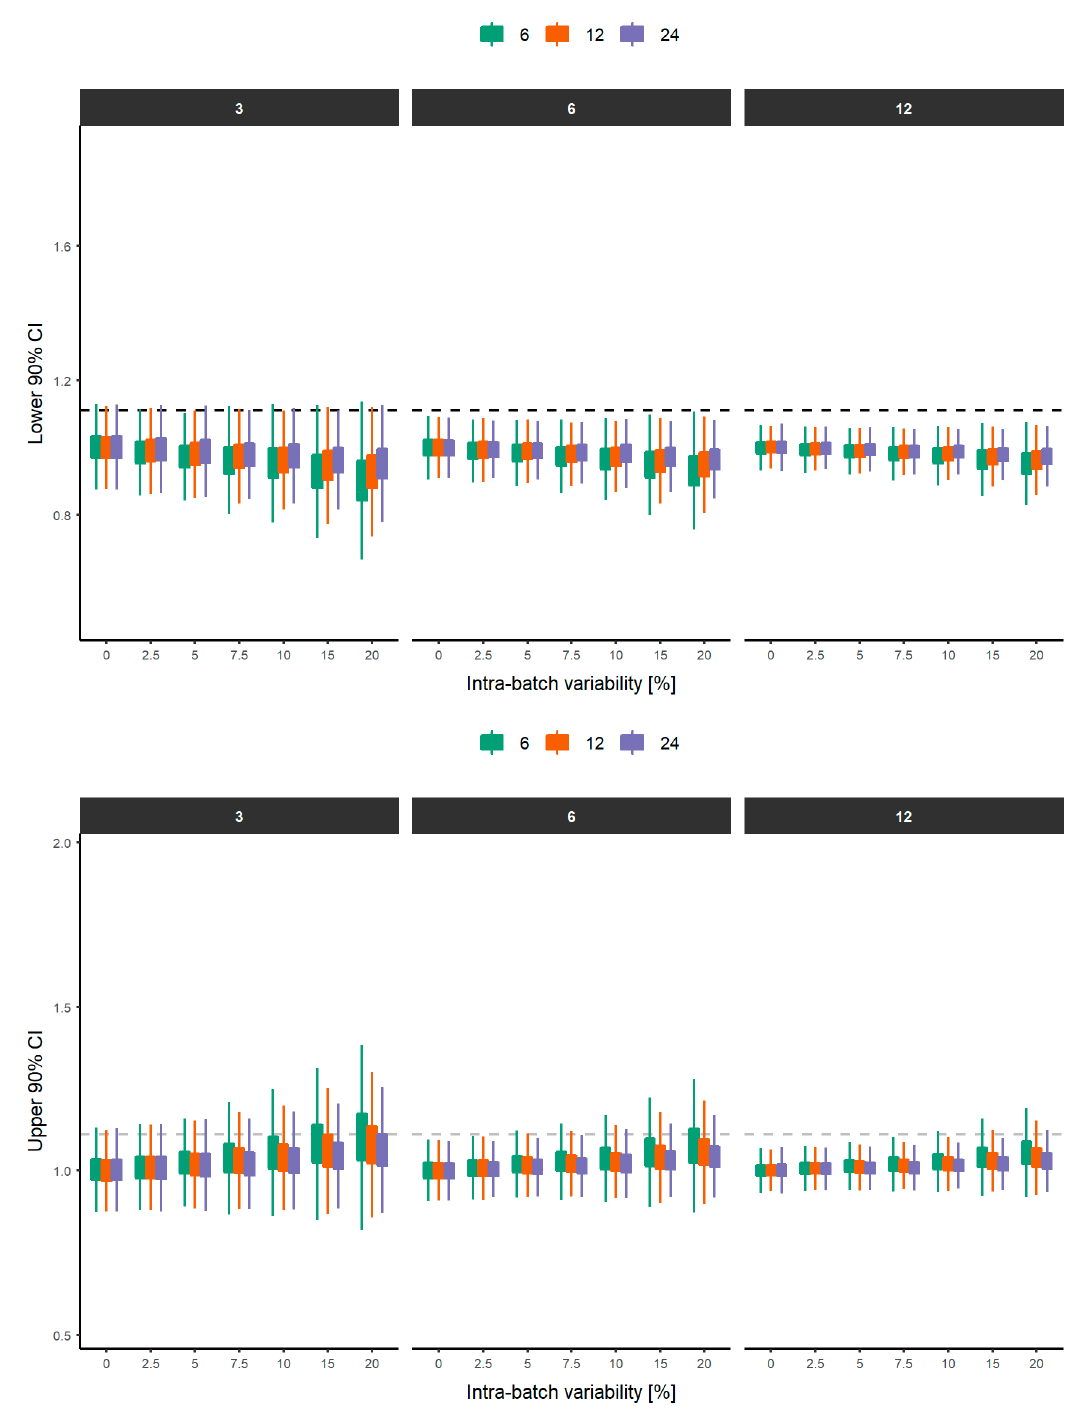
Figure 5. Distribution of the lower ( top ) and upper ( bottom ) 90% confidence intervals from each experiment ( n = 1000), stratified by the number of batches ( top ). Green, orange and purple boxplots represent the lower and upper 90% CI when 6, 12 and 24 units were considered, respectively. The box represents the interquartile range (IQR: Q1–Q3) and lines represent 1.5*IQR. Dashed grey line represent the lower (0.9) and upper (1.11) limit of the regulatory acceptance range.